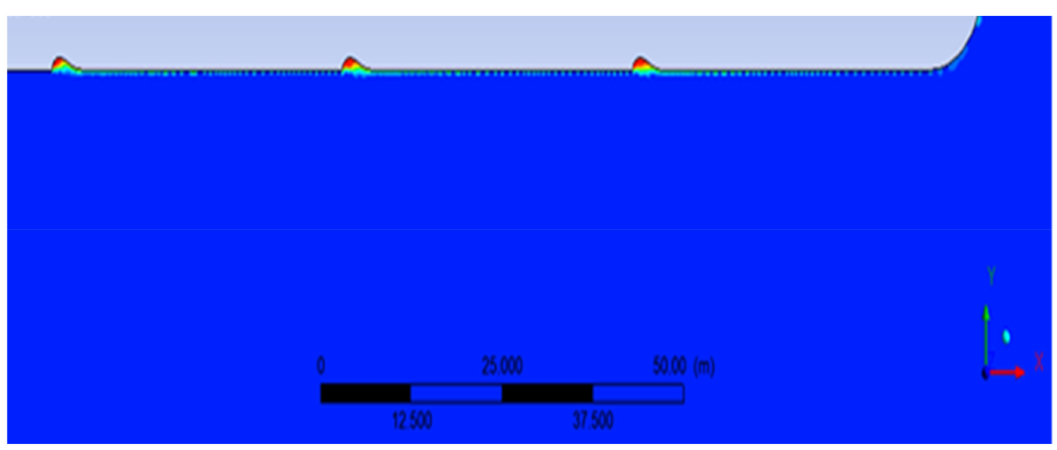
Figure 7. Snapshot from the operation of air lubrication system.